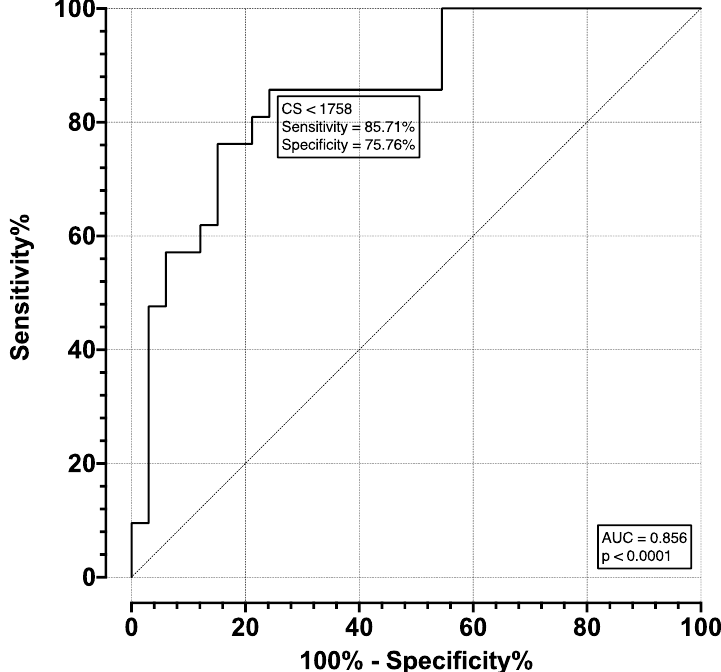
Figure 4. ROC for detection of at least moderate AS .